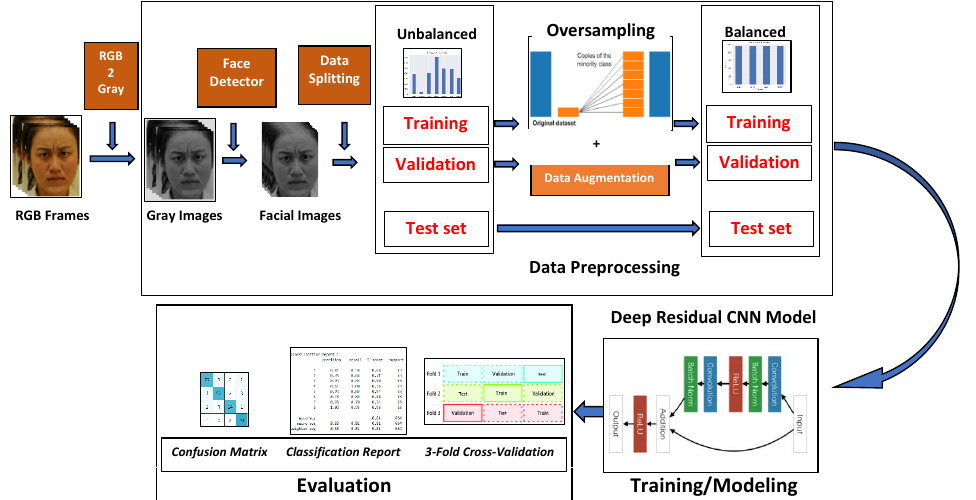
Figure 6. Pipeline for Training and Evaluation: Including Preprocessing, Data Partition, Data Augmentation, Training and